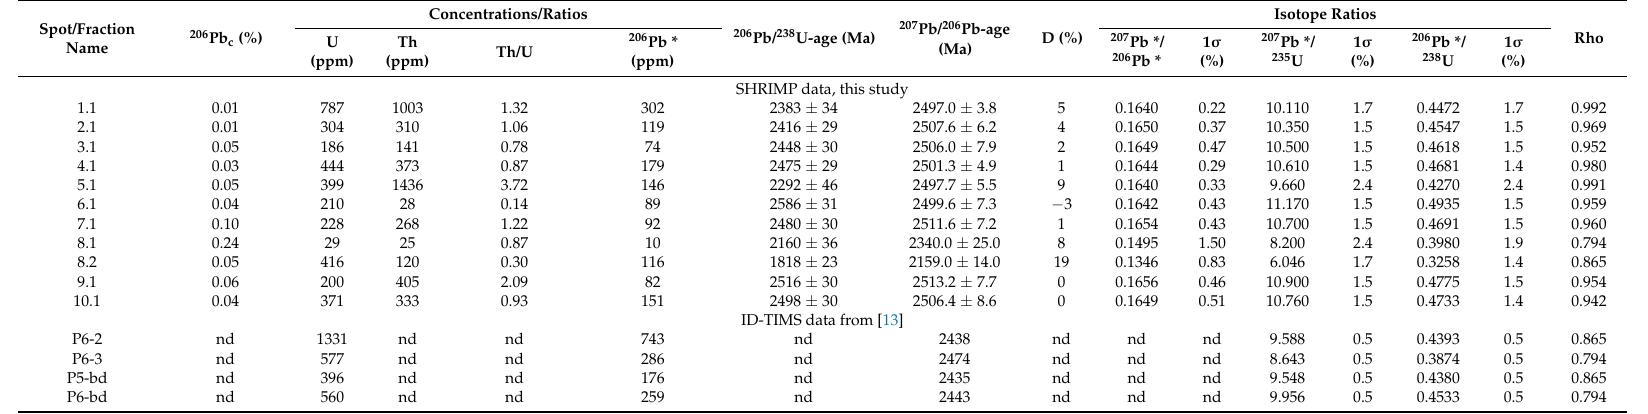
Table 1. SHRIMP and ID-TIMS U-Pb data for zircon and baddeleyite (bd) from the Main Anorthosite Layer of the West-Pana intrusion. Errors in isotopic ratios and ages are at the 1 σ level. Pb c and Pb* indicate the common and radiogenic lead portions, respectively. The error in standard calibration was 0.51%. Common Pb corrected using measured 204 Pb. Abbreviations: D, discordance; Rho, correlation coefficient; nd, no